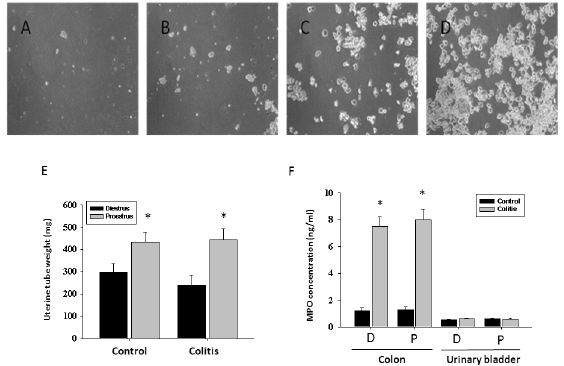
Figure 1. Evaluation of the stage of the estrous cycle in cycling female rats. Panels A–D show representative microphotographs of vaginal cytological samples taken from a female rat during diestrus 1 (metestrus, A), diestrus 2 (B), proestrus (C), and estrus (D). E, The uterine tube weight from rats in proestrus (N=7) is significantly greater than in rats in diestrus (N=6, p # 0.05) in both control and experimental groups of animals. F, Concentration of myeloperoxidase (MPO) enzyme is significantly elevated in the distal colon during colonic inflammation and unchanged in the urinary bladder of rats with active colitis. * - p # 0.05 to respective control group. D-diestrus,